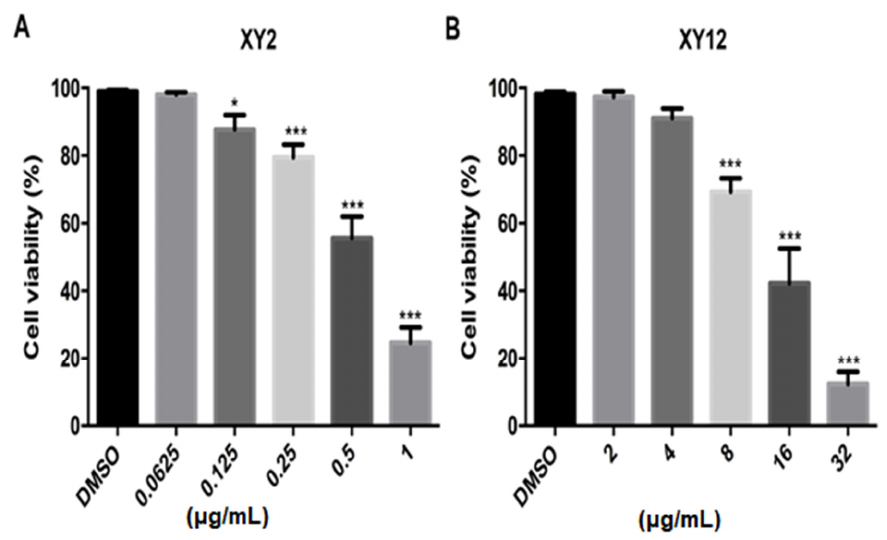
Figure 3. Cytotoxicity of compounds XY2 and XY12 detected by human umbilical vein endothelial cells (HUVECs). HUVECs were treated with different concentrations of compounds XY2 ( A ) and XY12 ( B ) for 24 h. Cell viability was detected by CCK-8 assay. Unpaired t test, * p < 0.05, *** p < 0.001. Finally, we compared the in vivo antifungal activity of XY12 and XY2 using the sys- temic candidiasis model. Treated with 10 mg/kg of XY12 , the average survival time and survival rate of mice increased significantly. However, XY2 did not show any protective efficacy against C. albicans infection at the dose of 10 mg/kg. When the dose reduced to 5 mg/kg, the protective effect of XY12 was lost. However, increasing the dose of XY12 not only failed to improve the protective effect, but also showed toxicity in vivo. The survival time of mice injected with 20 mg/kg of XY12 was shorter than that of mice injected with the solvent (Figure 4). Although XY12 showed moderate protective effect in vivo, it also caused abdominal irritation in mice, which was reflected by the writhing responses. Therefore, further structural modification of XY12 was required to enhance its antifungal effect and reduce its irritation to mammals.